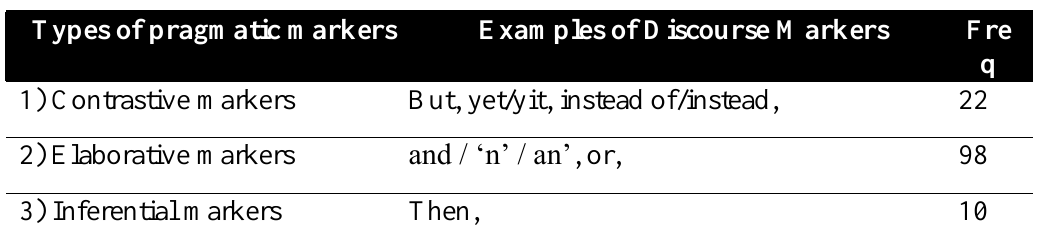
Table 4: Frequency Scale of Parallel